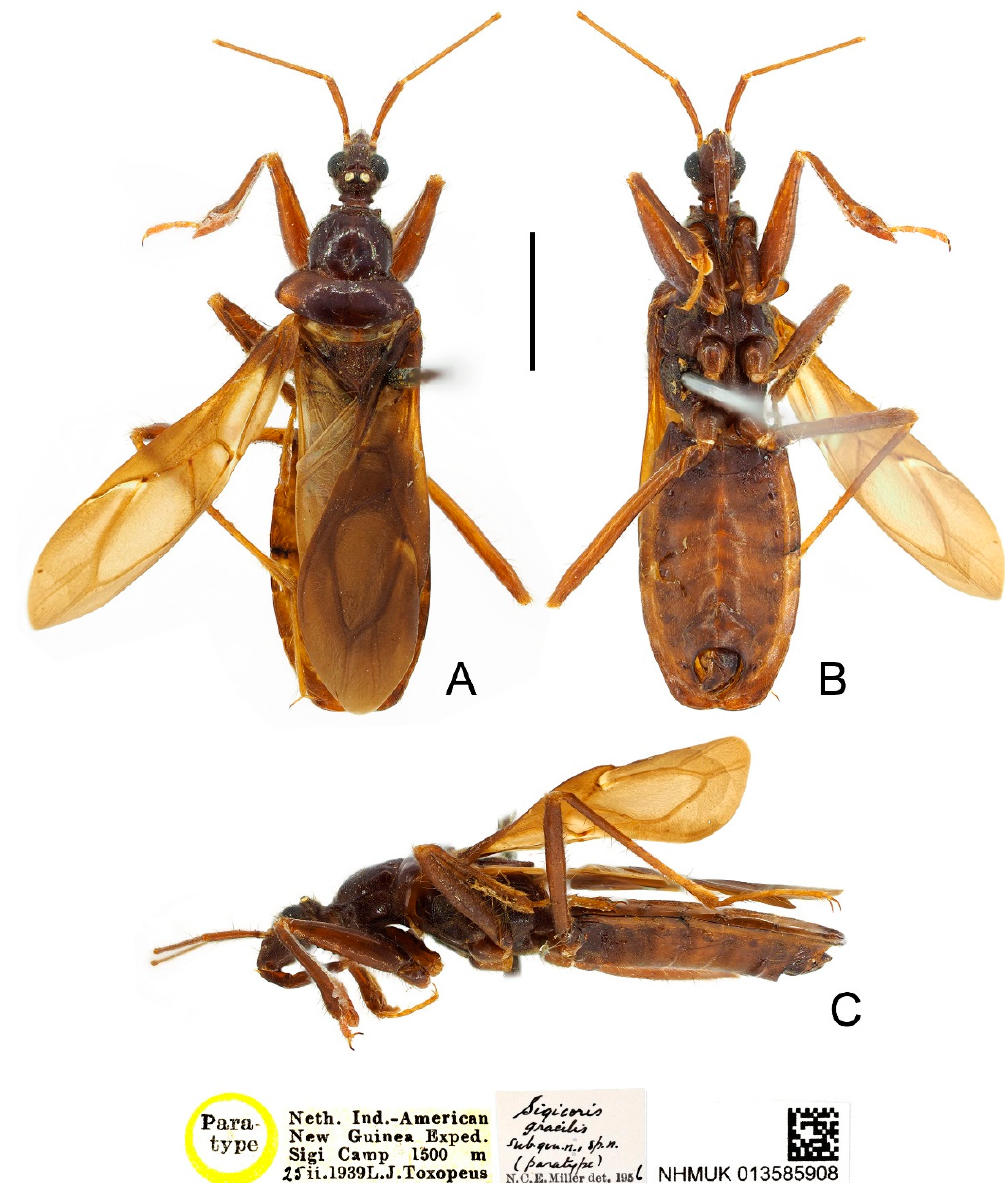
Figure 10. Sigicoris gracilis comb. nov. , paratype male, habitus. ( A ) Dorsal view. ( B ) Ventral view. ( C ) Lateral view. Scale bar = 3.00 mm.